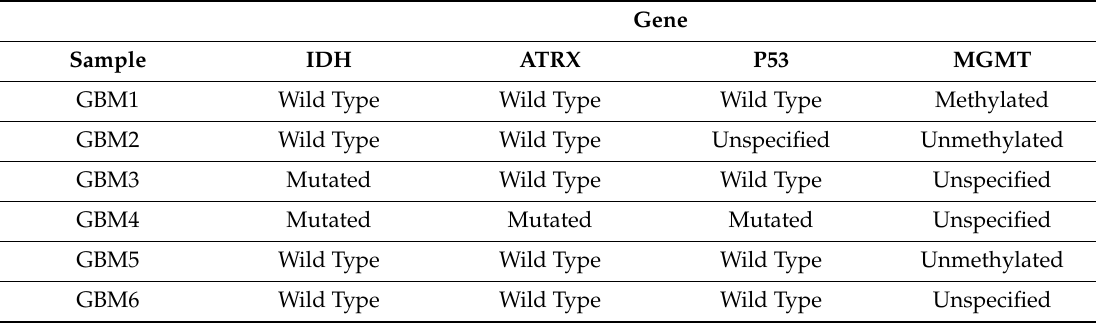
Table 1. Pathology data for each of the six GBM tumour samples.